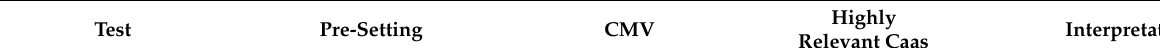
Table 8. Standardizing rheological methodology.